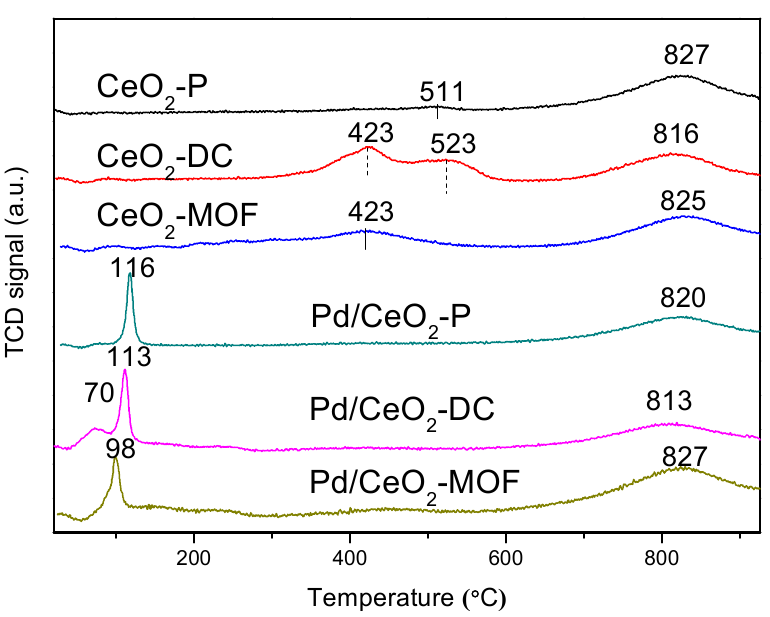
Figure 7. H 2 -TPR curves of the samples.